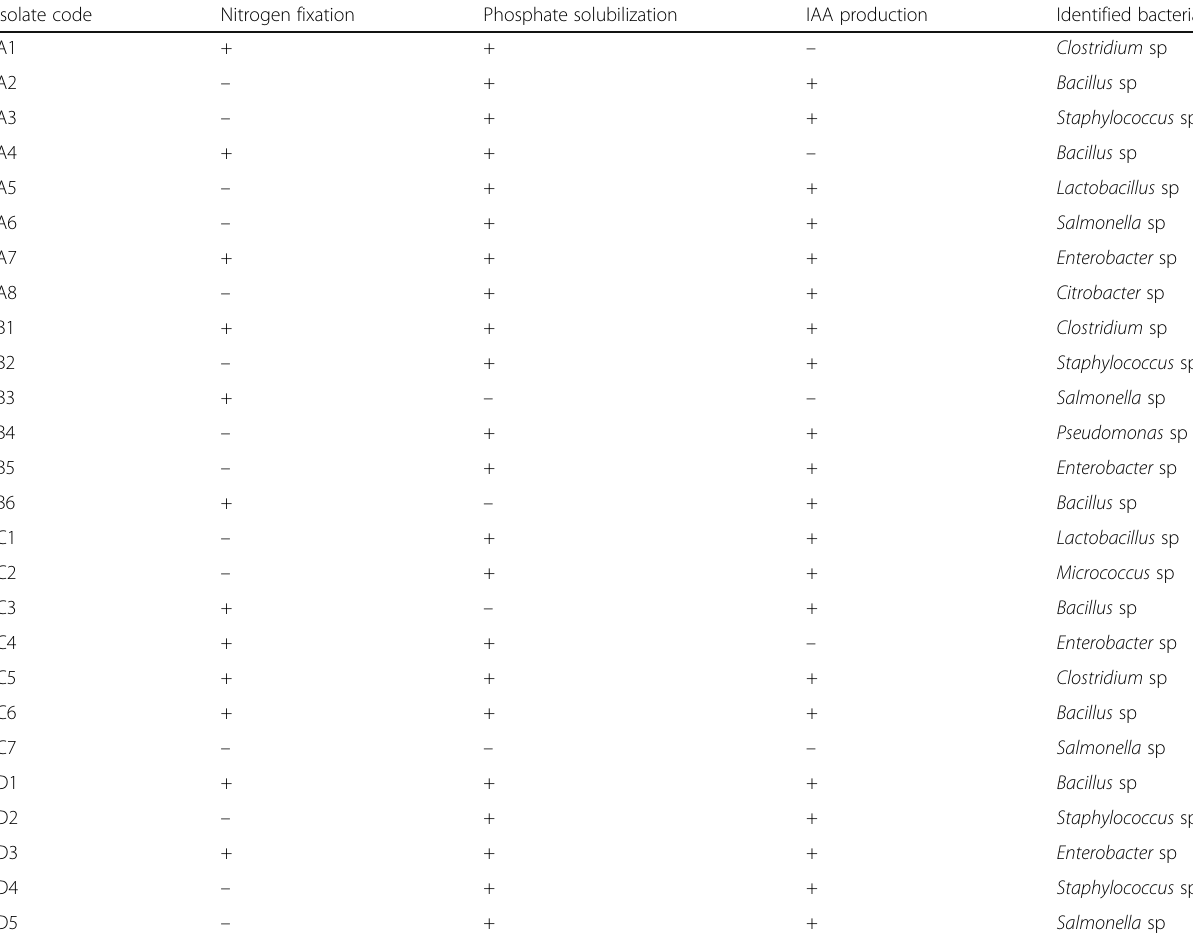
Table 2 Plant growth promoting properties of bacterial isolates from mesophilic digestate Isolate code